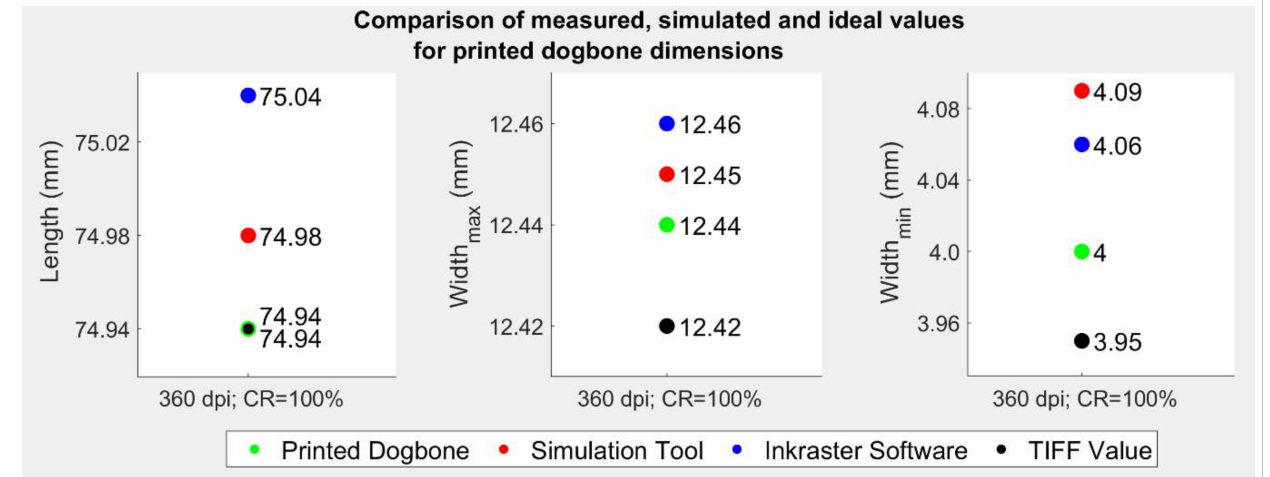
Figure 19. Results of the validation using printed dogbone parts (initial drop diameter = d 0 ; contact angle θ ; 360 dpi (X): 360.2837 dpi (Y); Coverage Percentage =